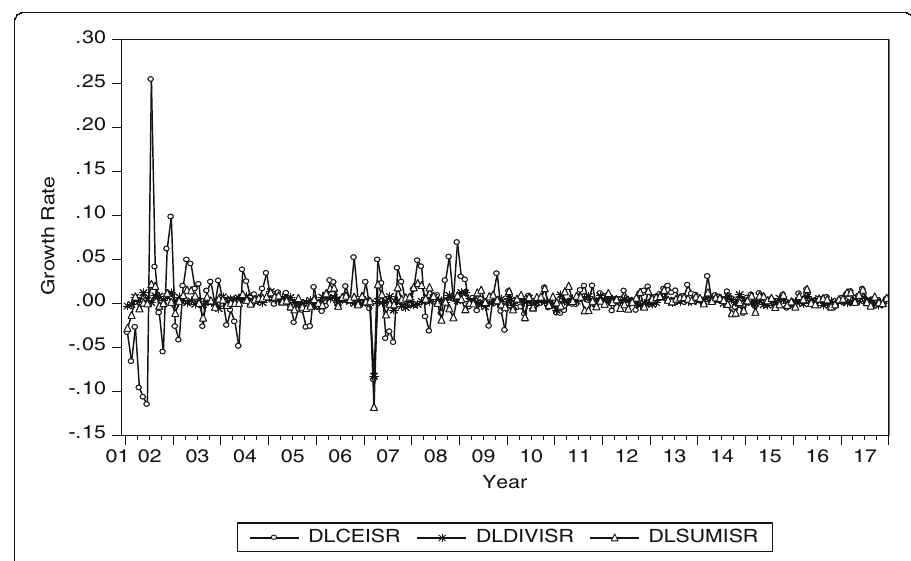
Fig. 4 Monthly Growth Rates of Monetary Aggregates of Israel. DLCEISR, DLDIVISR and DLSUMISR are log differences of CE, Divisia index and Simple-Sum measures for Israel respectively. The numbers 01 through 17 on the horizontal axis represent the years 2001 through 2017